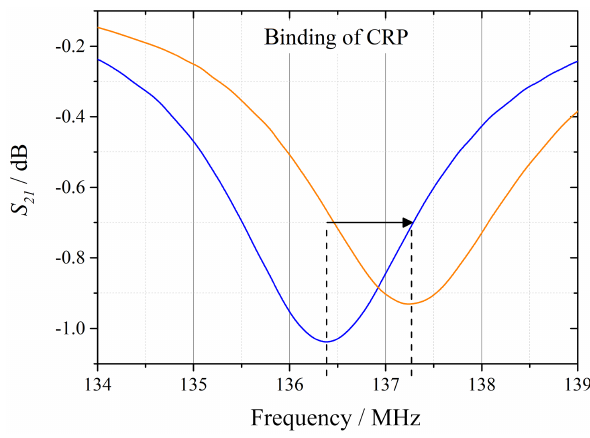
Figure 22. S 21 with deionized water as sample before and after binding of CRP.